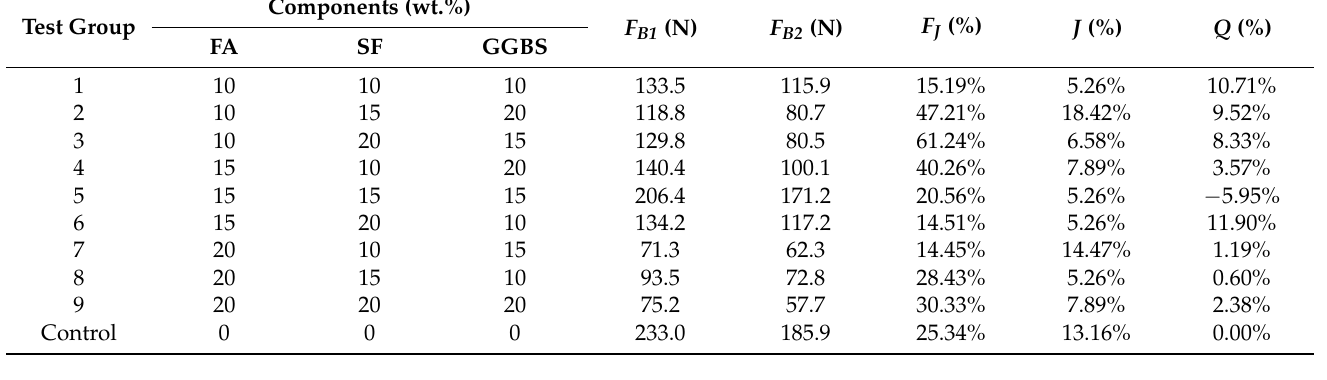
Table 5. Summary of printable performance test and calculation results.